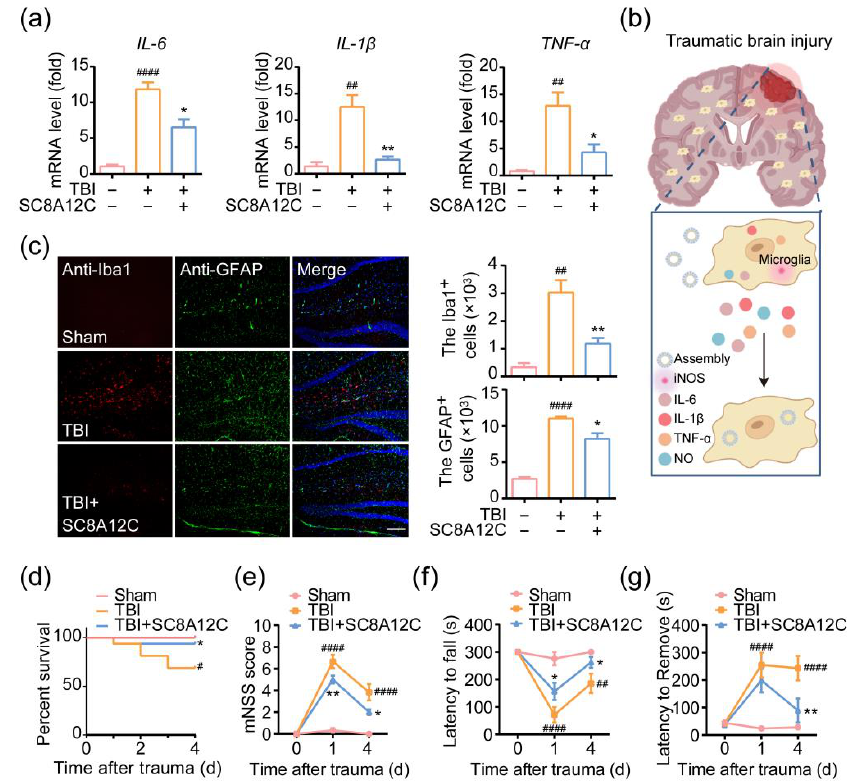
Figure 6. ( a ) RT-qPCR quantitative analysis of IL-6 , IL-1 β , TNF- α levels in the injured cortex at 1-day post-injury of sham mice, TBI mice with or without SC8A12C treatment (n = 3); ( b ) schematic diagram of SC8A12C treating TBI by inhibiting microglia activation; ( c ) fluorescence images and counting of Iba + and GFAP + cells in the penumbral regions of brain slices from sham, TBI, and TBI + SC8A12C groups (n = 3). Scale bar, 50 μm ; ( d ) survival rates of sham mice, and TBI mice with or without SC8A12C administration (n = 6) during 4 days; ( e ) the mNSS test at 1 and 4 days post-injury in sham mice, TBI mice with or without SC8A12C administration (n = 6); ( f ) rotarod analysis of motor function at 1, 4 days post-injury in sham mice, TBI mice with or without SC8A12C administration (n = 6); ( g ) the adhesive tape removal test, the latency to remove for ipsilateral forepaw was evaluated at 1 and 4 days post-injury in sham mice, TBI mice with or without SC8A12C administration (n = 6). # p < 0.05, ## p < 0.01, #### p < 0.0001 vs. sham group; * p < 0.05, ** p < 0.01 vs. TBI group.